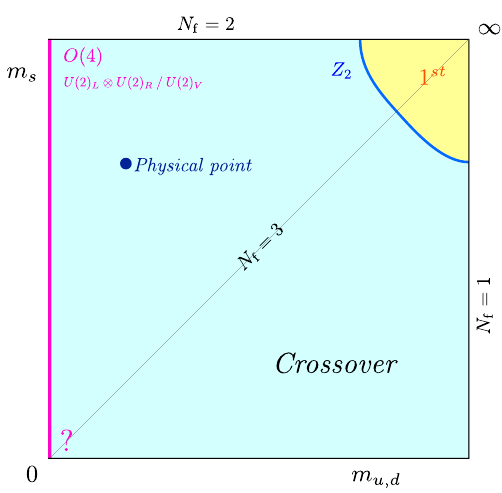
Figure 13. The Columbia plot in the continuum, as predicted by our